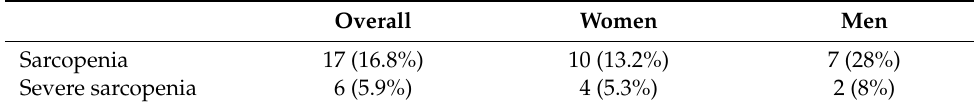
Table 2. Prevalence of sarcopenia and its diagnostic criteria.